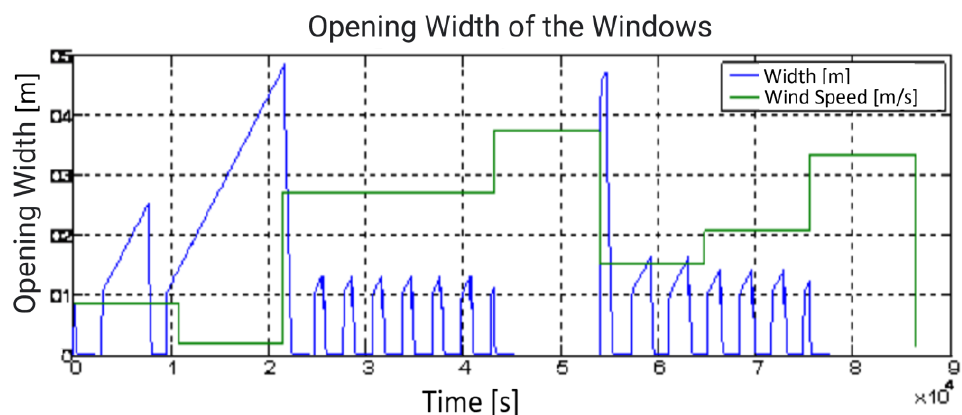
Figure 25. Control results: IAQ control, windows opening (MV).